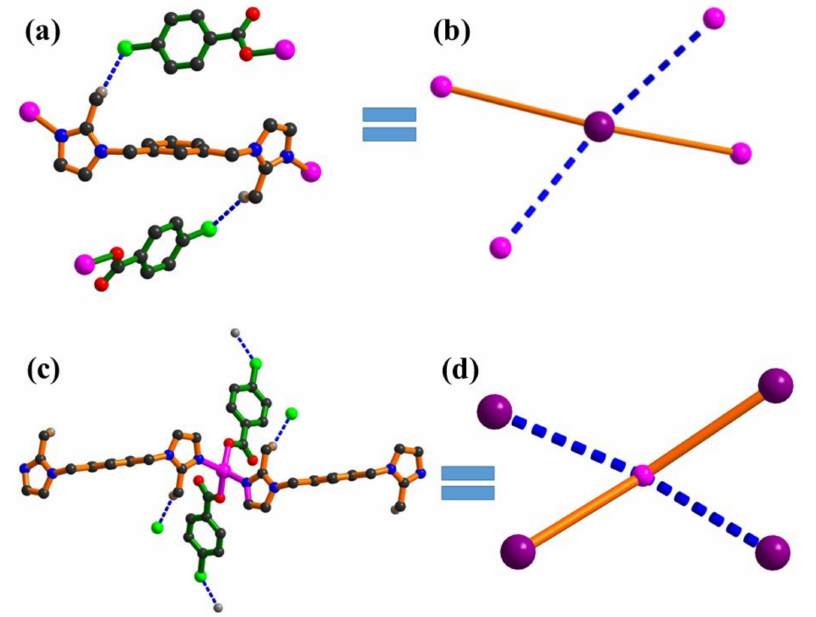
Figure 3. ( a ) The enlarged C8–H8A ··· Cl1 interactions in 1 . ( b ) The [Co 4 (bmimb)(pca) 2 ] 6+ unit simplified as a four connected node (violet ball represents the core of the bmimb ligand, and pink ball represents Co 2+ ; solid lines represent bmimb ligands, and dash lines represent C–H ··· Cl hydrogen bonds). ( c ) The Co(pca) 2 (bmimb) 2 unit linked by four symmetry-related C8–H8A ··· Cl1 interactions in 1 . ( d ) The Co(pca) 2 (bmimb) 2 unit simplified as a four connected node (violet ball represents the core of the bmimb ligand, and pink ball represents Co 2+ ; solid lines represent bmimb ligands, and dash lines represent C–H ··· Cl hydrogen bonds).